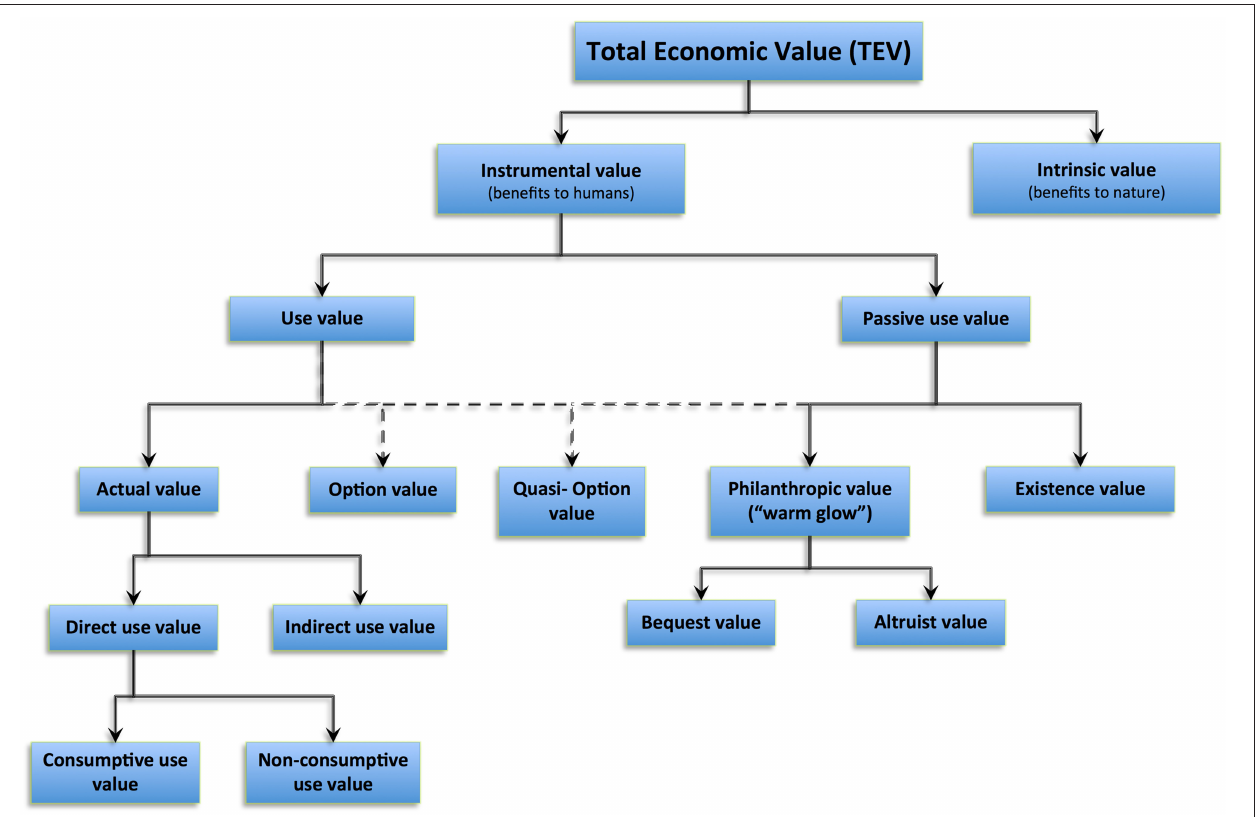
FIGURE 10 | Schematic diagram of the subdivision of the Total Economic Value (TEV) into different types of values. The “intrinsic” or “inherent” value is included explicitly in this diagram, following Davidson (2013). There is no consensus in the literature on a single standard categorization or terminology of values. Therefore, the key purpose of this figure is to show how complex and multifaceted the overall value of an object or action can